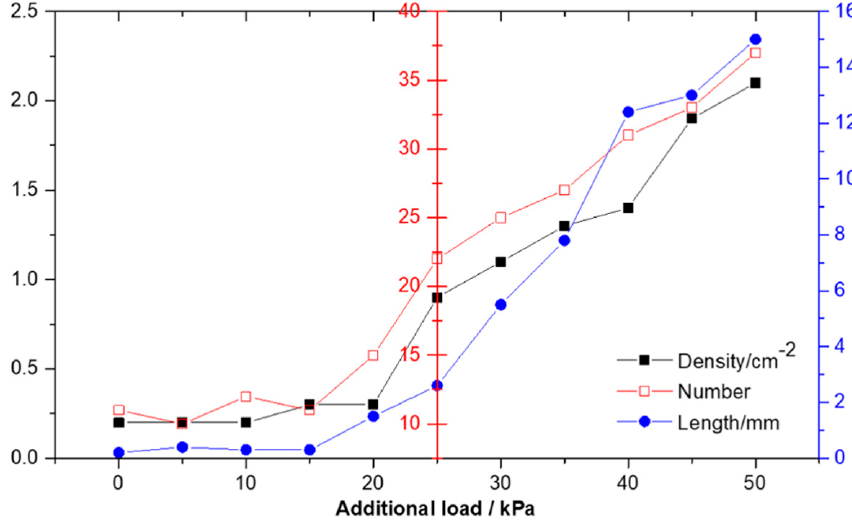
Figure 10. Statistical results of surface scratches under different processing pressures.